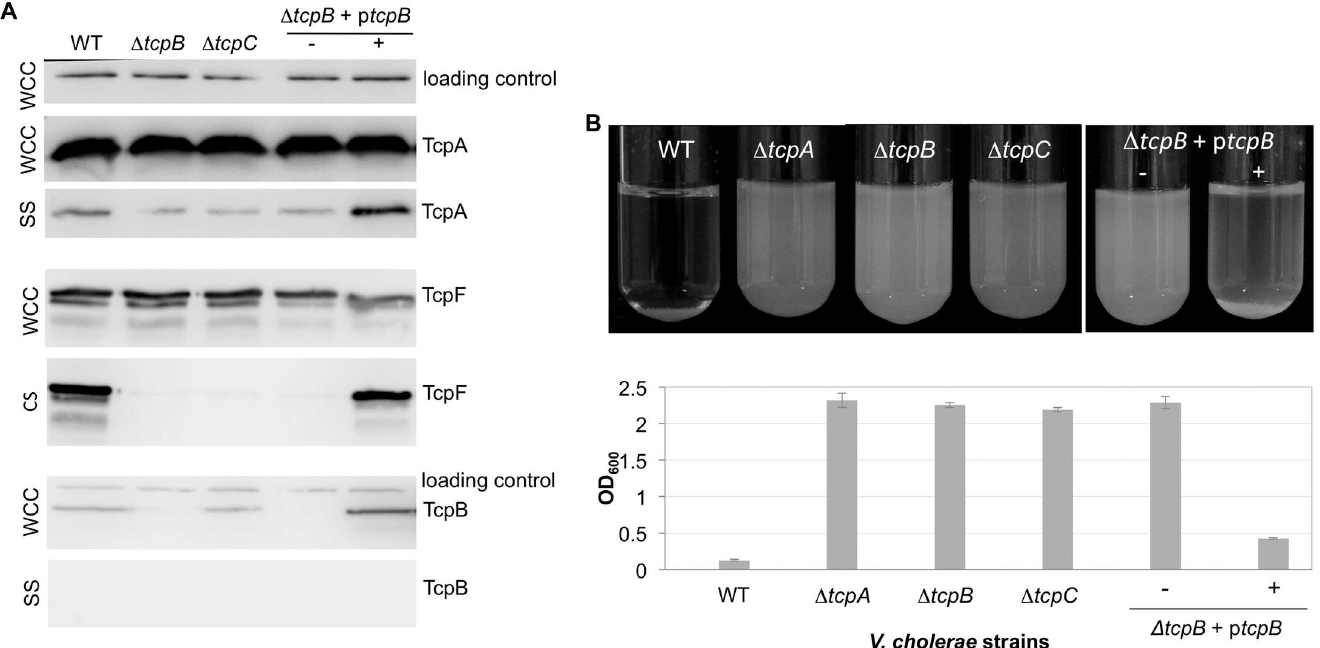
Fig 3. V . cholerae requires TcpB for efficient pilus assembly and functions. (A) Immunoblots of V . cholerae wholecell culture (WCC), sheared culture supernatant(SS) and cleared culture supernatant(CS) fractions probedwith antibodiesagainst TcpA, TcpF and TcpB, as indicatedby the labeled protein bands. SS for the TcpA and TcpB blots was preparedby homogenizing the cells to shear the pili then removingintact cells by centrifugation. The SS fractions were toppedup with PBS to a volume matchingthat of the WCC, and equal volumes (25 ul) of each sample were loadedonto the gel. TcpA in the SS fraction of the Δ tcpB and Δ tcpC mutants may represent contamination from cell membranes due to the shearingmethod or membraneblebbing due to high levels of TcpA that accumulate in the inner membrane. Secreted TcpF is detected in the CS fraction, obtainedby removing V . cholerae cells by centrifugation and filtration without shearing. TcpF often appearsas a doubletin immunoblots. The lower band of the doubletappearsto be a proteolysed form of TcpF lackingthe N-terminal ~25 amino acids. This segment is not resolved in the TcpF crystal structure suggestingit is flexible, which may explain its protease sensitivity [10]. The Δ tcpB strain is complementedwith p tcpB without (-) and with (+) 0.001% rhamnose inducer.The loadingcontrol is an unknown~60 kDa protein present in the WCC fraction and detected by the Strep -Tactin-HRP conjugate. (B) V . cholerae autoagglutinationas a function of TcpB expression. Cell cultures are shown after overnight growth followedby 15 min stationary incubation at room temperature (top panel). The OD 600 of the culture supernatant after the cells have settled is plotted for each sample in the bottom panel. The more completethe autoagglutination the lower the OD 600 value. Valuesare averaged for 3 experiments; error bars represent